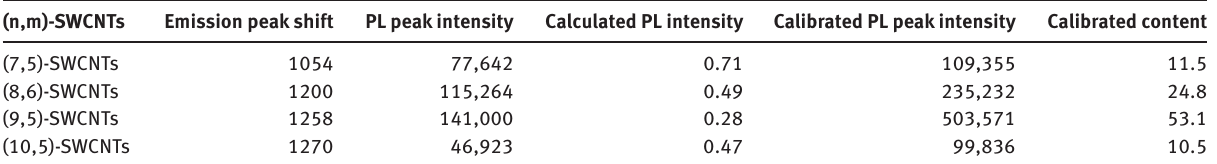
Table 1: Calibrated contents of the SWCNTs species deduced from the PLE mapping of the PFT-sorted s-SWCNTs. (n,m)-SWCNTs